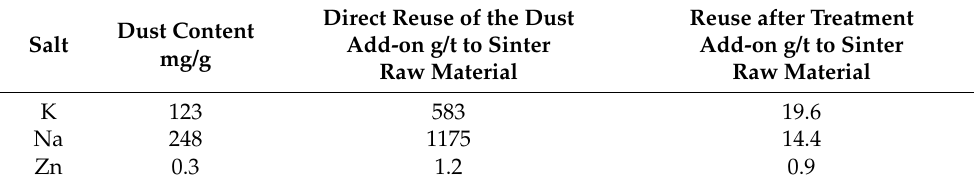
Table 6. Dust content and contribution to the total sinter of untreated or treated